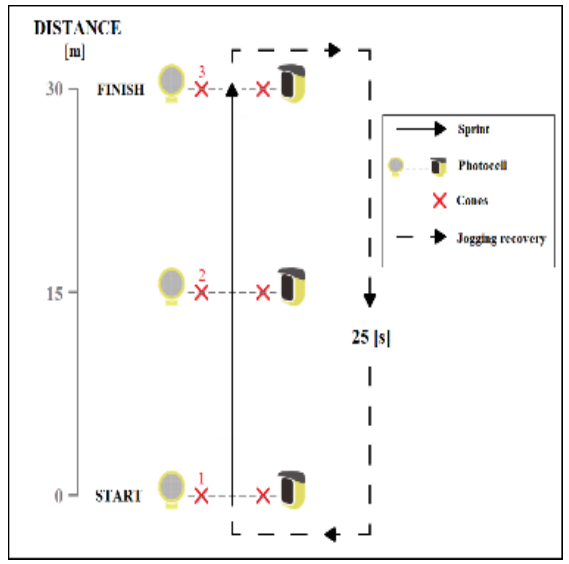
Figure 2. The repeated straight sprint test (7 × 30 m). A player started from net N.1, with one leg placed on the starting line and the other leg placed behind the starting line. The player started sprinting to net N.3 (finishing line) once the examinator signaled the start. Photocells used for measuring time were placed 1 m high and were located on the starting line, 15 m from the starting line, and on the finishing line. The player returned to the starting line right after he finished sprinting. The player ran a total of 7 sprints with 25 s of active rest (low-intensity running). The player had 25 s to return to the starting line after he finished each sprint. When the examinator counted down the last 3 s, the player sprinted again and both the total time as well as the time taken on singular distances were measured.